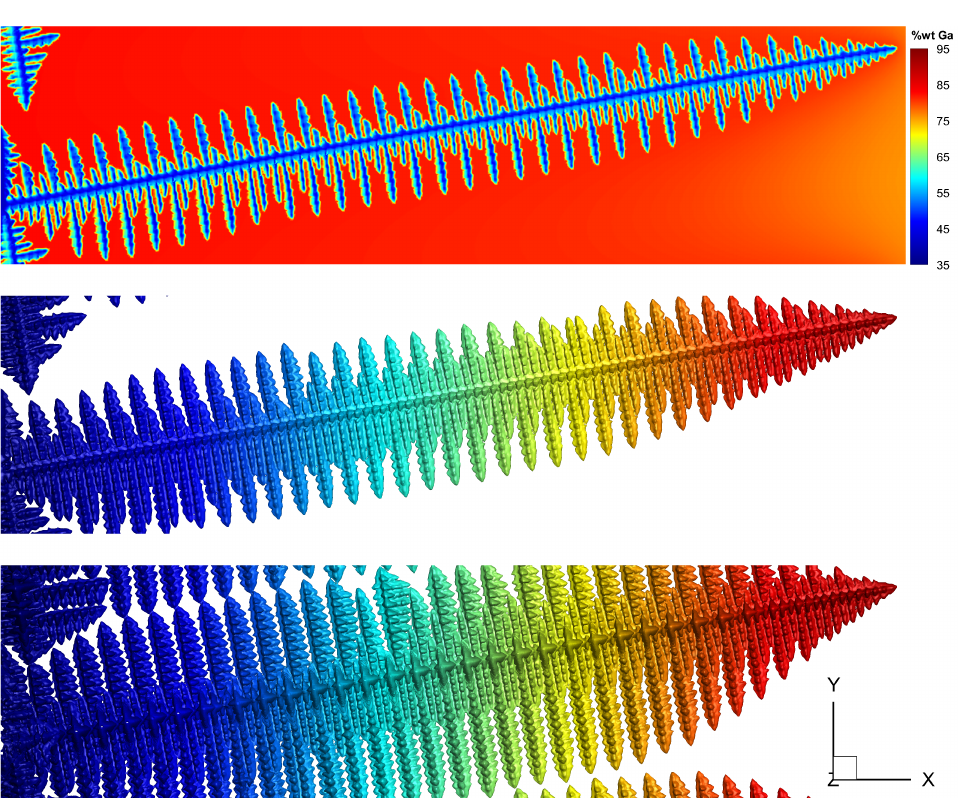
Figure 3. Final microstructures of simulated dendrites grown to 6 mm under different modelling assumptions. Top: concentration profile of a 2D dendrite (used for plane stress and strain). Middle: 3D surface of a dendrite grown in a thin sample. Bottom: 3D surface of a dendrite grown in a normal width